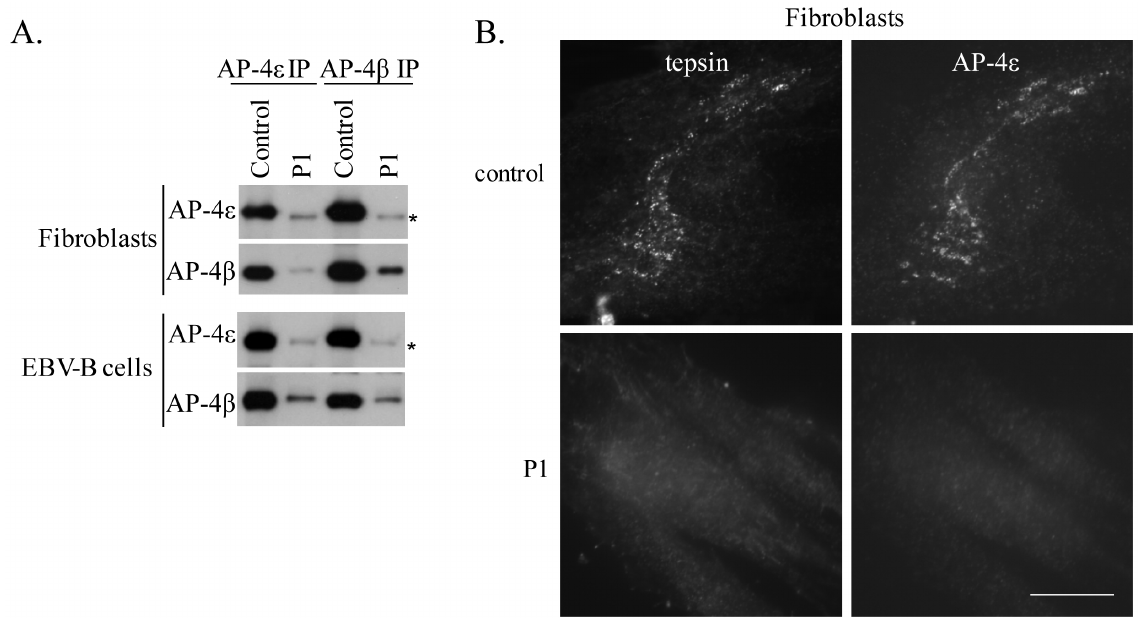
Figure 3. Immunoprecipitation and immunofluorescence of the AP-4 complex in P1. A). EBV-B cells and SV40 fibroblasts from P1 and a healthy control were subjected to immunoprecipitation under native conditions with antibodies against AP-4 e or AP-4 b , and the immunoprecipitates were then western blotted with antibodies against AP-4 e or AP-4 b . Equal amounts of protein were used for immunoprecipitation from patient and control cells. A small amount of AP-4 b is coassembled with AP-4 e , and the AP-4 e assembled with AP-4 b in P1 appears to be slightly smaller (AP-4 e *) than the AP-4 e in control cells. B). Fibroblasts from P1 and a healthy control were double-labeled for AP-4 e and the AP-4-associated protein tepsin. Note the specific loss of AP-4 e and tepsin from the cells of P1. Bar 20 m m. These experiments were carried out at least three